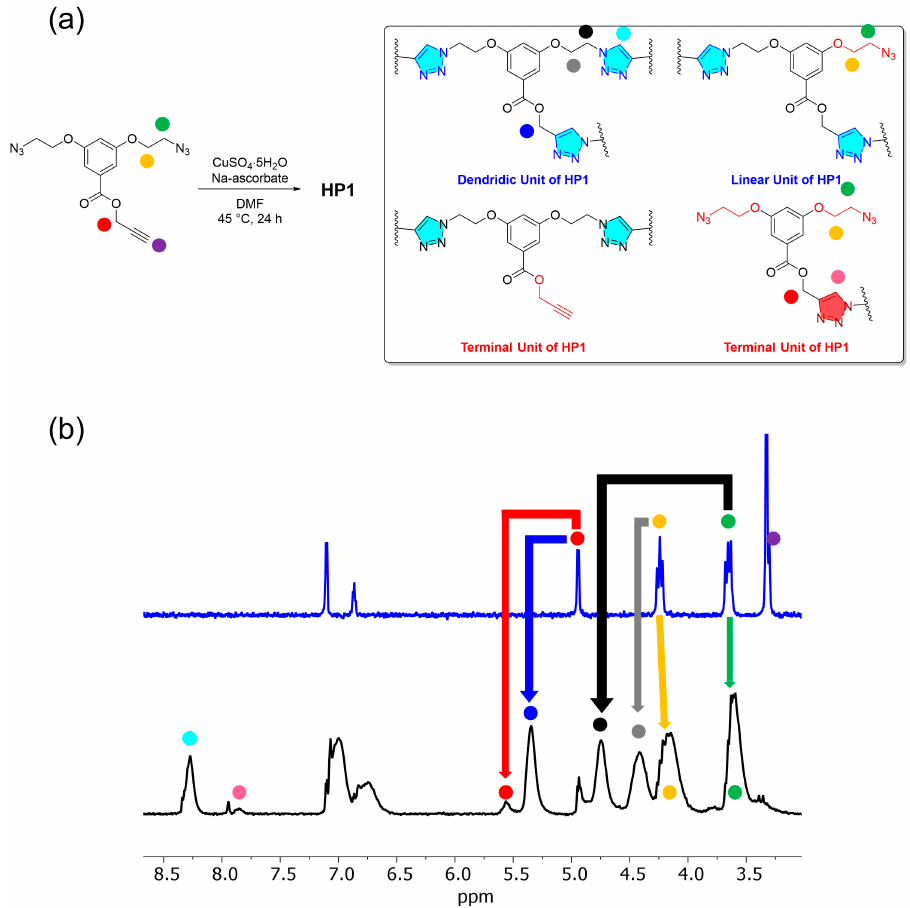
Figure 2. ( a ) Polymerization scheme for monomer 5 and the possible terminal, linear, and dendritic fragments for HP1 ; and ( b ) stacked 1 H NMR spectra in DMSO- d 6 of monomer 4 (blue line) and hyperbranched polymer HP1 (black line).